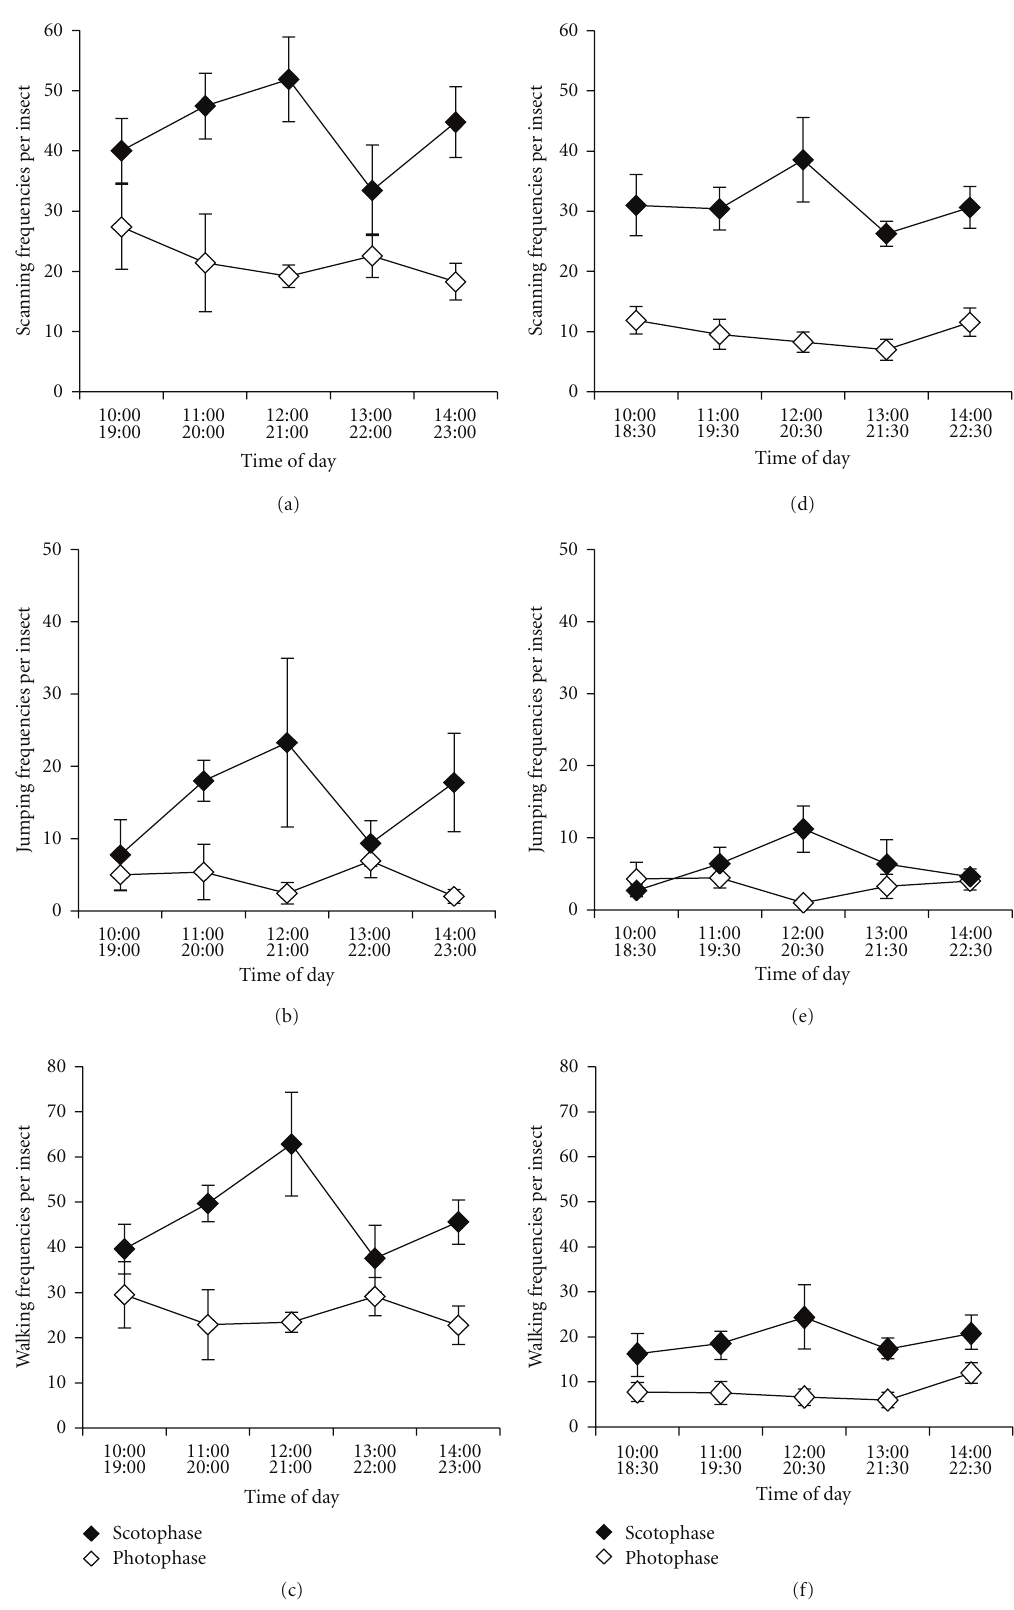
Figure 2: Activity of mature field-collected ((a)–(c)) and laboratory-reared ((d)–(f)) solitarious males. Bars represent standard errors ( ± SE); N = 80 insects used for each of the three